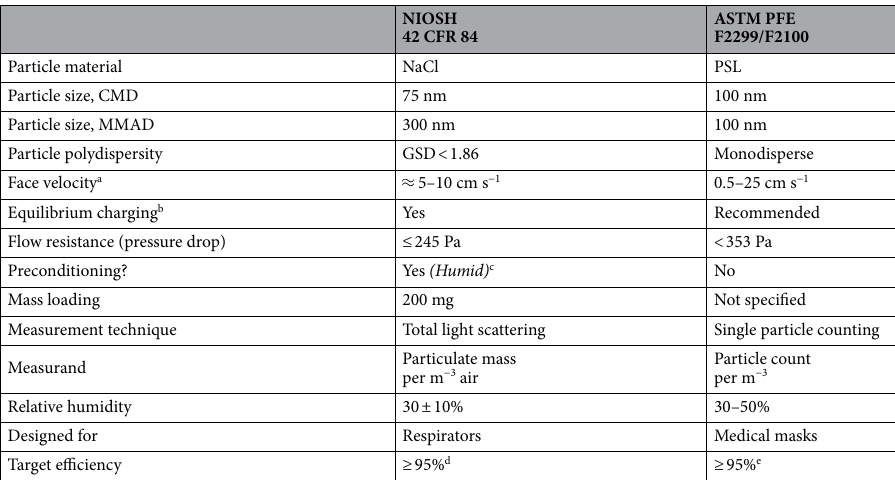
Table 2. Summary of the parameters which differ between the NIOSH and ASTM F2299/F2100 test methods. CMD count median diameter, MMAD mass median aerodynamic diameter, PSL polystyrene latex spheres, PFE particle filtration efficiency, GSD geometric standard deviation. a For N95 respirators the flow rate, not face velocity, is specified. Our quoted range is the 95% confidence interval from N95 surface areas measured by Roberge et al. 43 as described in the text. b Neutralizing to a Boltzmann charge equilibrium state is particularly necessary after producing the test aerosol with a nebulizer. c Preconditioning at 85% ± 5% RH, 38 °C ± 2.5 °C for 25 h ± 1 h. d For N95 respirators. e For Level 1 barrier. Level 2 and 3 require ≥